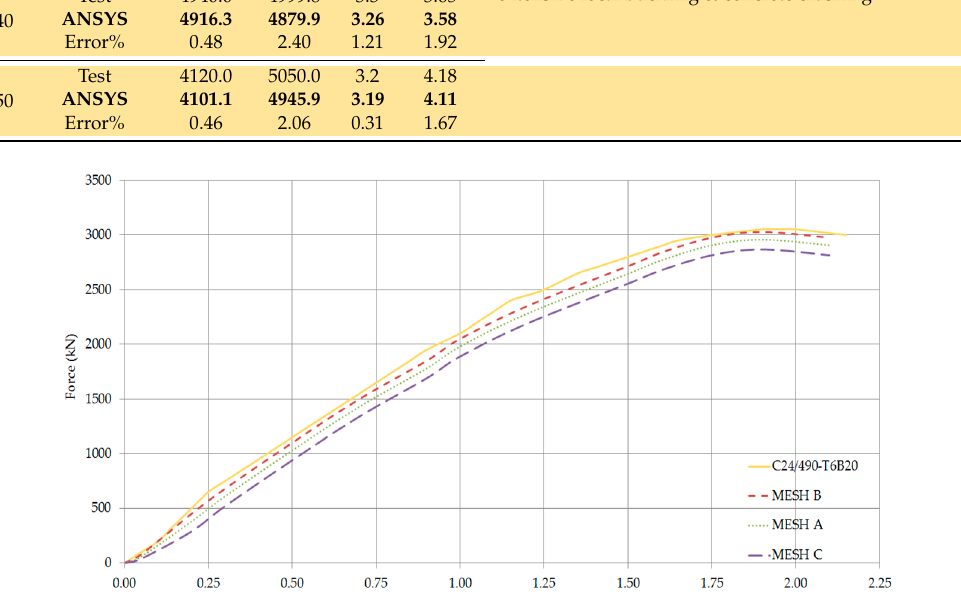
Figure 18. Axial force—Shortening Curves of C24/490-T6B20 (Comparison of mesh densities).